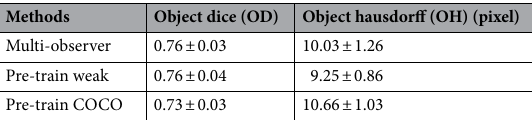
Pairwise validation Object dice (OD) Object hausdorff (OH)